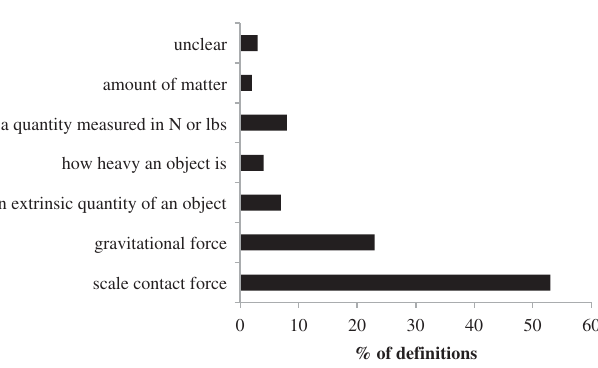
FIG. 3. Definitions of weight,